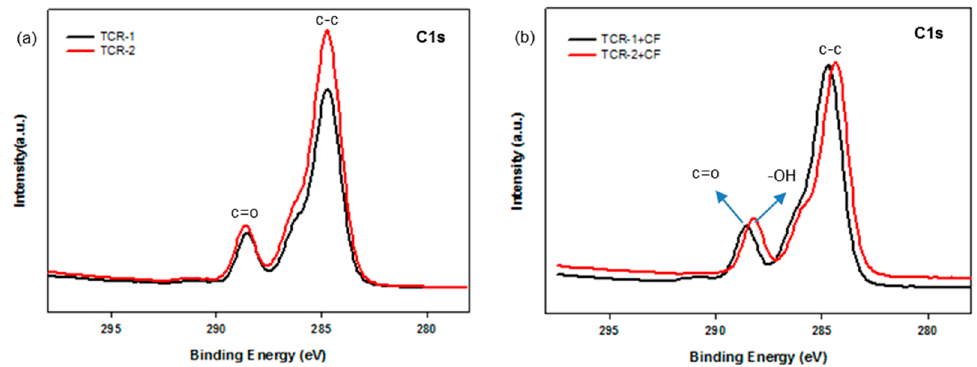
Figure 10. High-resolution XPS spectra with peak-fitting in the carbon BE region: ( a ) TCR-1, TCR-2, ( b ) TCR-1, 2, and CF nanocomposites.